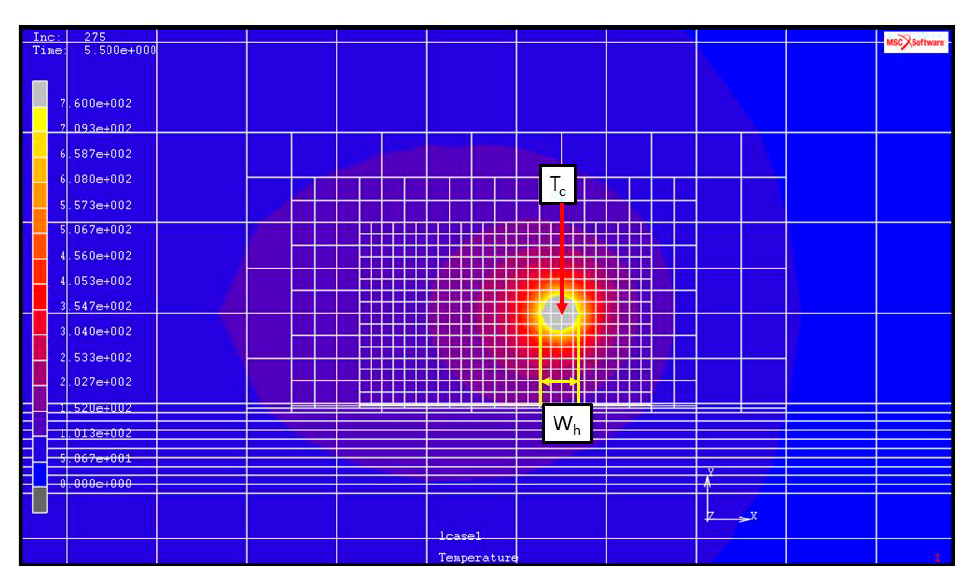
Figure 4. Heat source distributions of various transverse electromagnetic modes (TEM) [25].